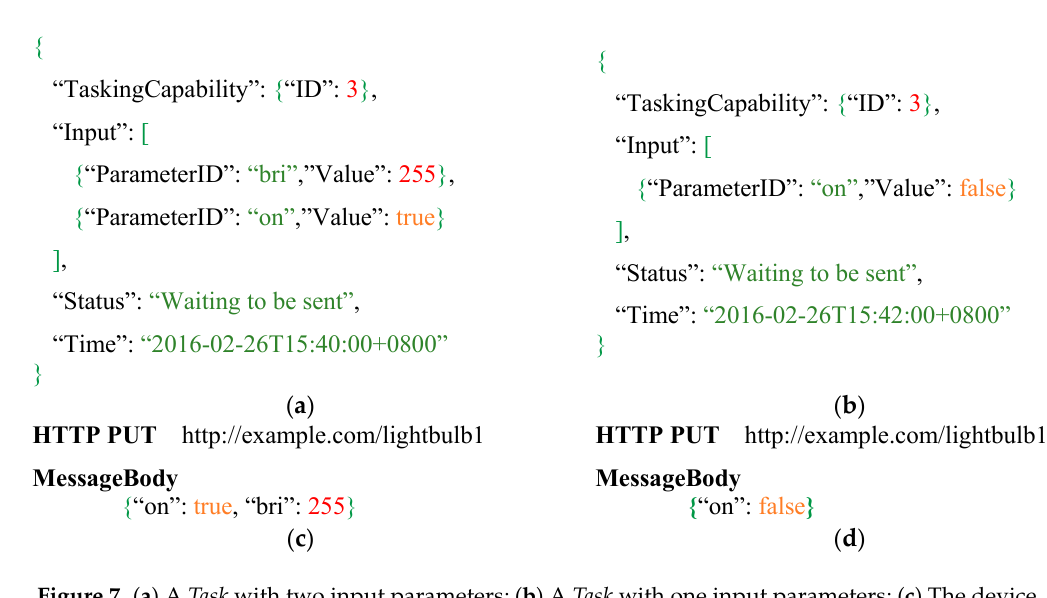
Figure 7. ( a ) A Task with two input parameters; ( b ) A Task with one input parameters; ( c ) The device request corresponds to the two-input-parameters Task ; ( d ) The device request corresponds to the one-input-parameter Task .